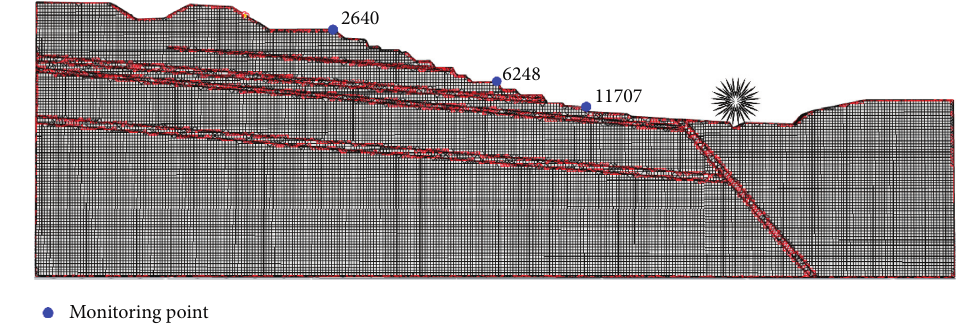
Figure 8: The mesh model used in the calculations.